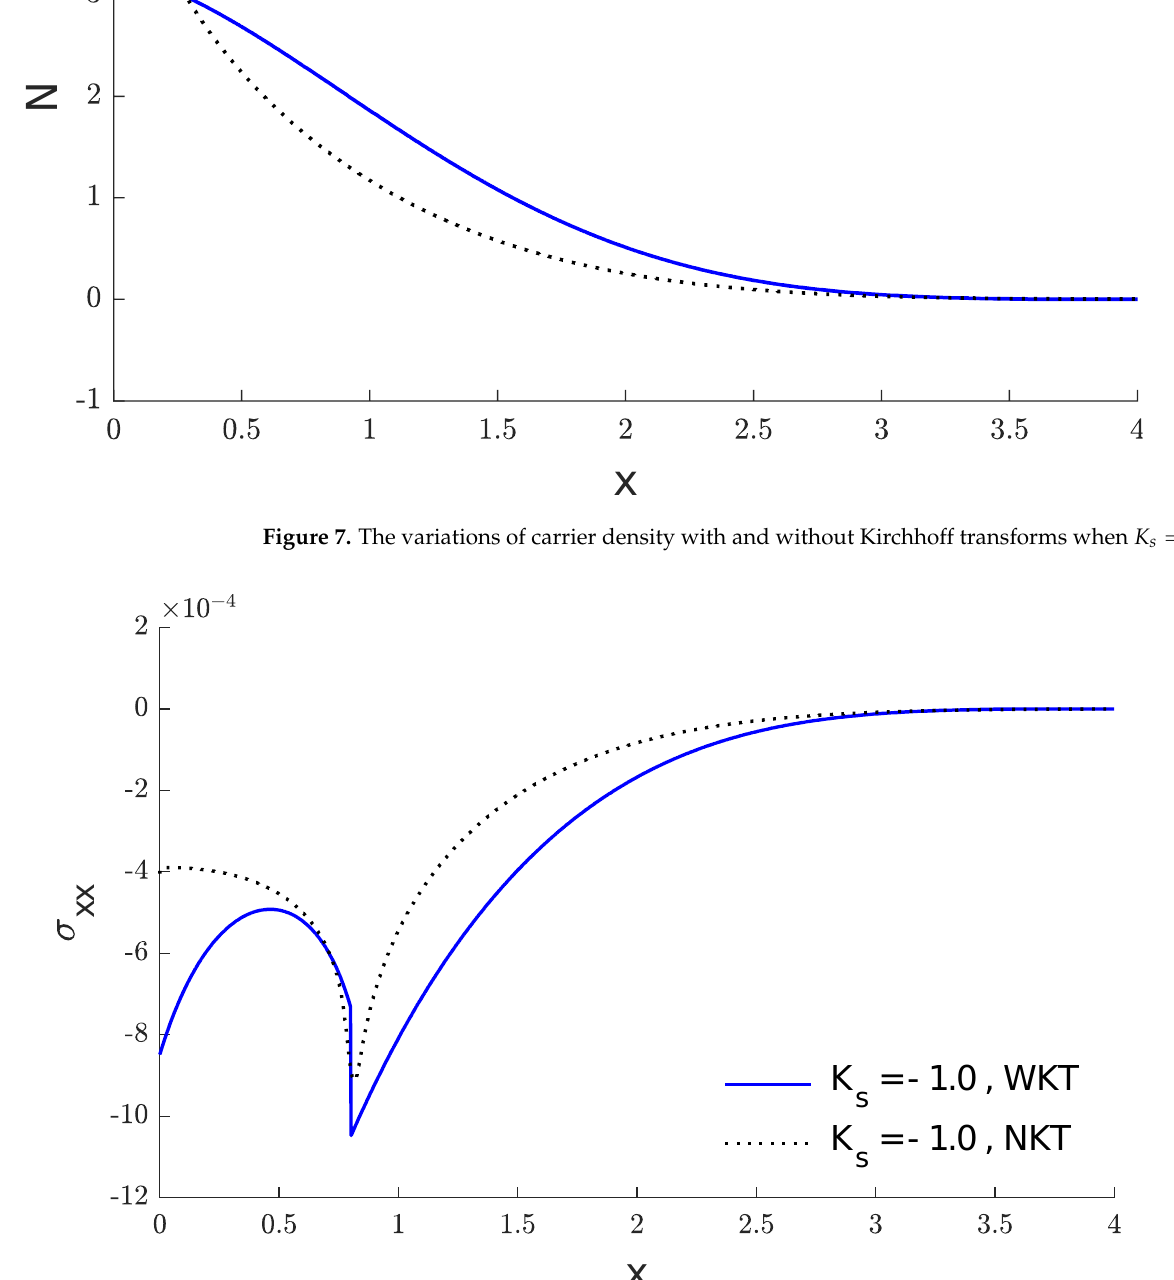
Figure 8. The variations of stress with and without Kirchhoff transforms when 𝐾 𝑠 = −1 .